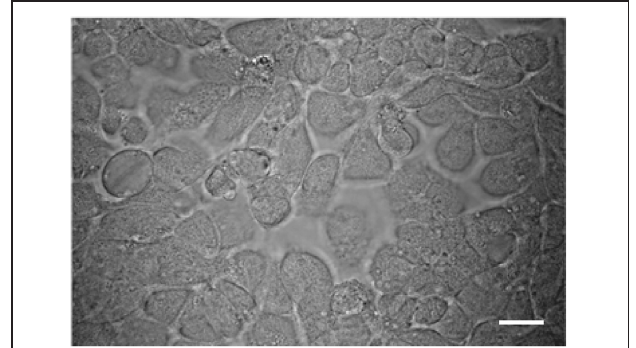
FIGURE 1 | Light micrograph of R. dorsalis vector cells in monolayer (VCM) after 90 passages. Bars, 50 µ m.